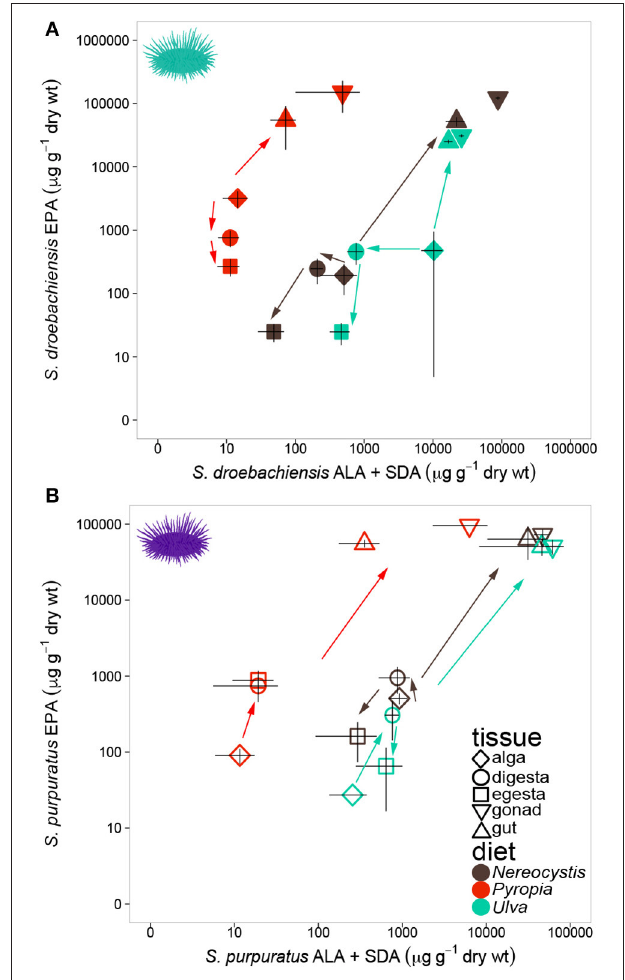
FIGURE 6 | Concentrations (mean ± SD , µ g g − 1 dry weight of precursor FA 18:2 ω 6 (LIN) of tissues and 20:4 ω 6 (ARA) in tissues collected from feeding assays with (A) S. droebachiensis and (B) S. purpuratus . Arrows indicate urchin modification of diet algae as they are digested and subsequently incorporated into new urchin tissue. Concentrations are plotted on a logarithmic scale.